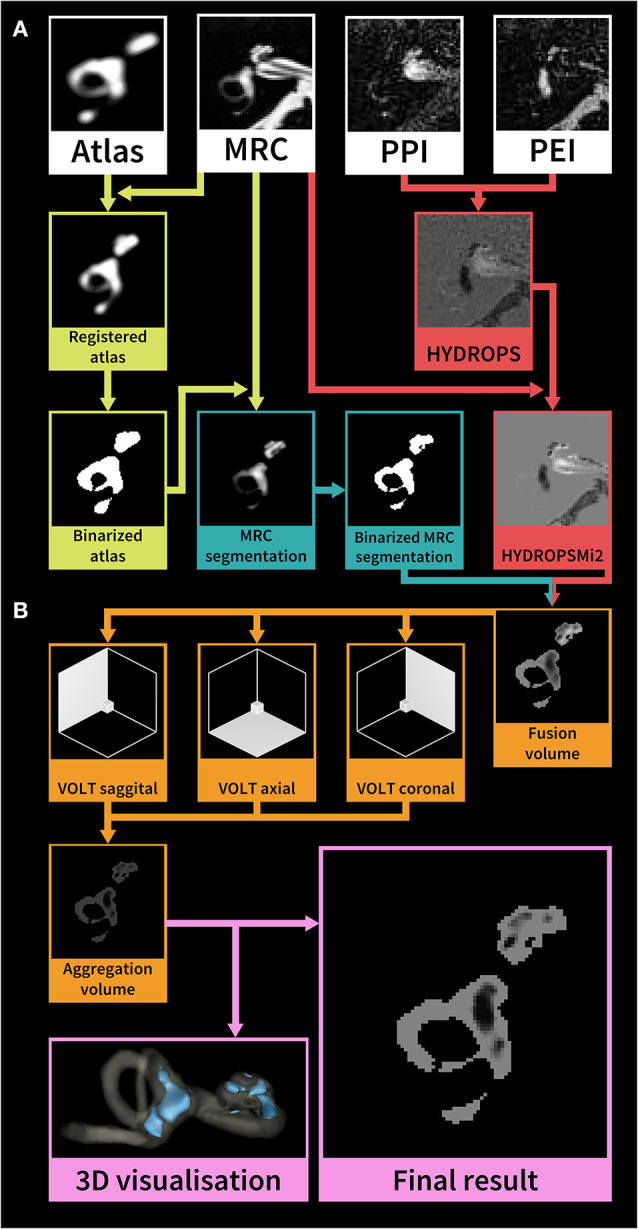
Overview of the HYDROPSMi2 volumetric quantification pipeline. The flowchart shows a step-by-step overview of an example of an exemplary single subject's right inner ear. Each color corresponds to a different processing step. The pipeline is divided into (A) pre-processing and (B) volumetric local thresholding (VOLT) processing steps: First, a probabilistic atlas of the bony labyrinth (22) is co-registered to the MRC image, binarized using 3D-thresholding and then used to segment the MRC image (green steps). Second, the HYDROPSMi2-image is created by subtracting the PEI from the PPI and multiplying the result with the MRC image (red steps). Third, a fusion volume is created from the binarized MRC-segmentation and the HYDROPSMi2-image (red and blue arrows). VOLT (23) is then performed with two algorithms and two spatial resolutions on each of the reconstructions. All VOLT-results are reconstructed into one direction and aggregated into one volume (orange steps). This aggregation volume can be used to visualize the endolymphatic space (ELS) in 3D or as a quantification of the ELS in mathematical analysis (pink steps). HYDROPSMi2, Hybrid of the reversed image of positive endolymph signal and native image of positive perilymph signal multiplied by T2; MRC, Magnetic resonance cisternography; PPI, Positive perilymph image; PEI, Positive endolymph image.